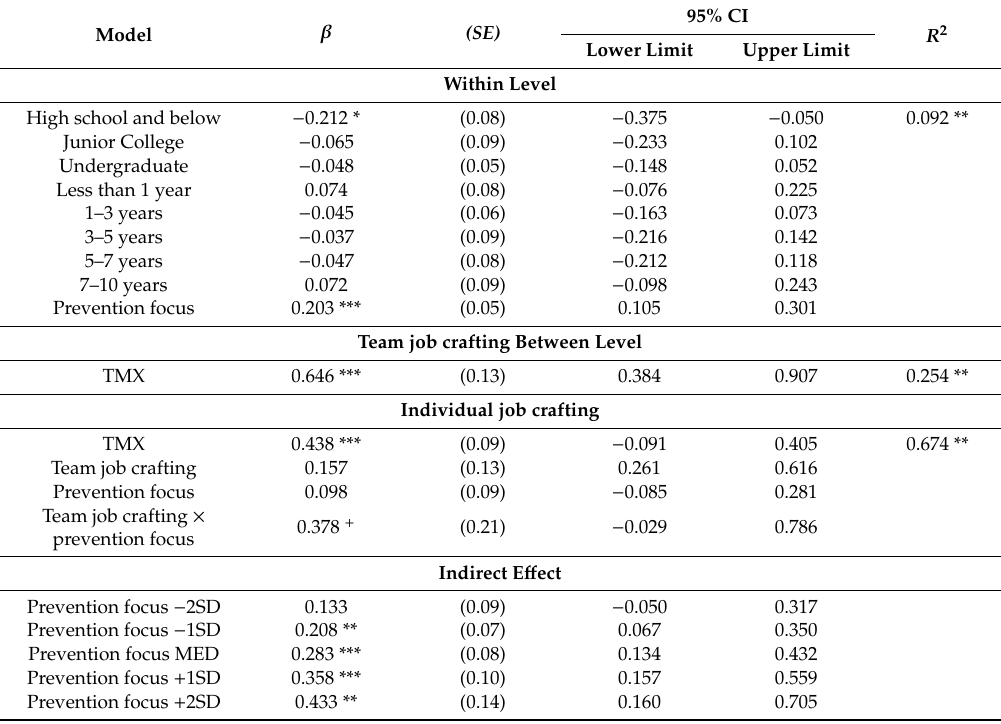
Table 11. Moderated mediation of prevention regulatory